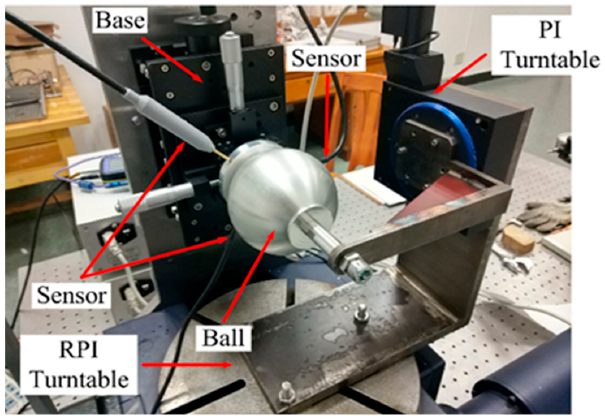
Figure 12. Image of experimental device prototype.